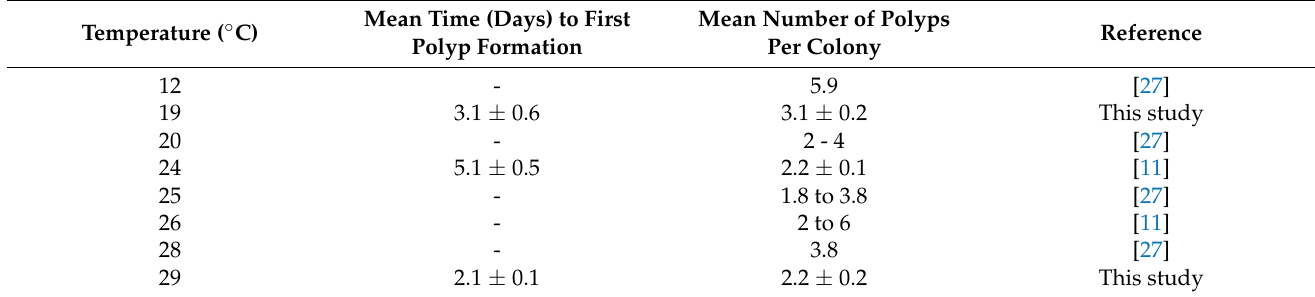
Table 3. Review on multi-polyp colony development at various